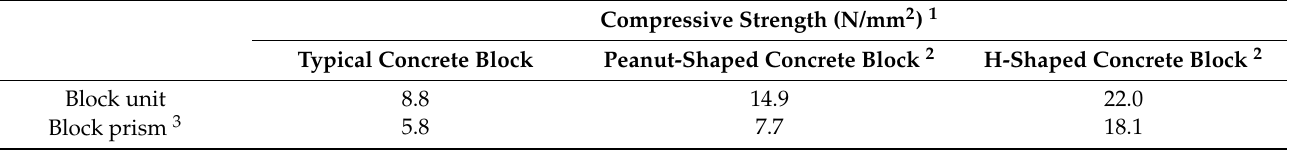
Table 1. Mechanical properties of each concrete block.